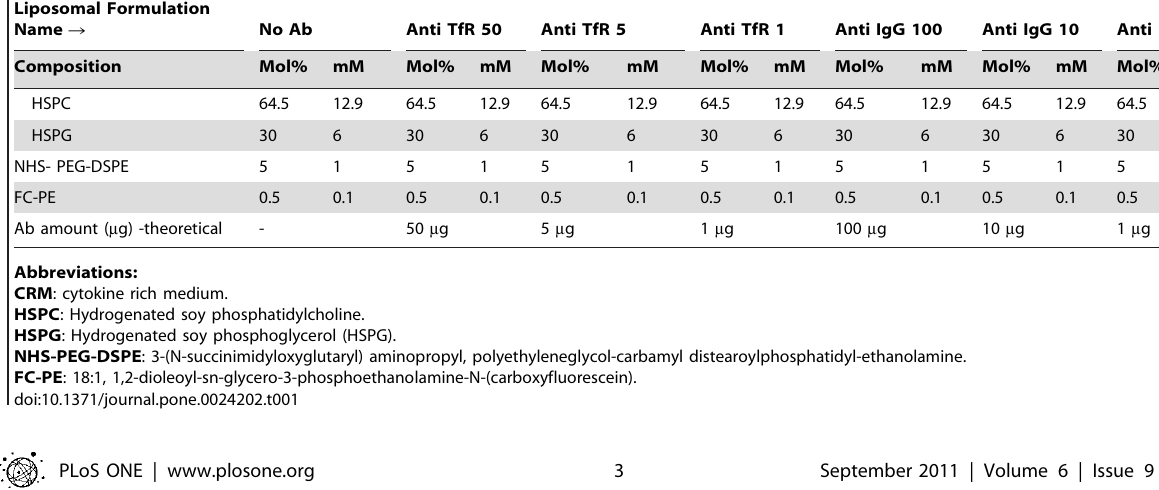
Liposomal Formulation Name